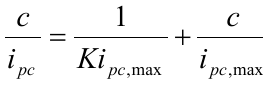
(from internal 6 vs. concentration of Fc + pc